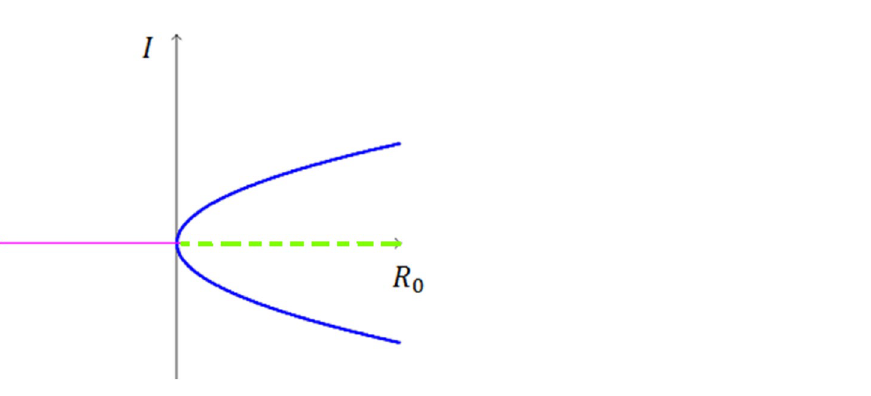
Figure 3. Pitchfork